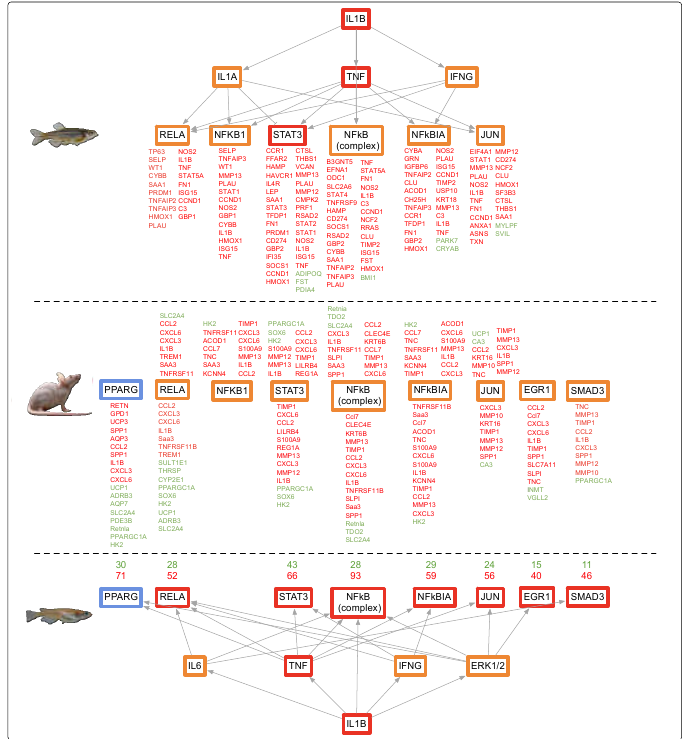
Figure 4. IL1B controls expression of many shared mid-level regulators in the zebrafish (top), medaka (bottom), and mouse (middle) skin datasets, including the key immune and inflammation APR regulator TNF. Genes in red and green are modulated differentially expressed genes (DEGs) and genes in orange and blue are predicted by IPA to be up and down, respectively. Due to the robust dataset in medaka, the number of genes up- and down-modulated are listed in red and green, respectively.